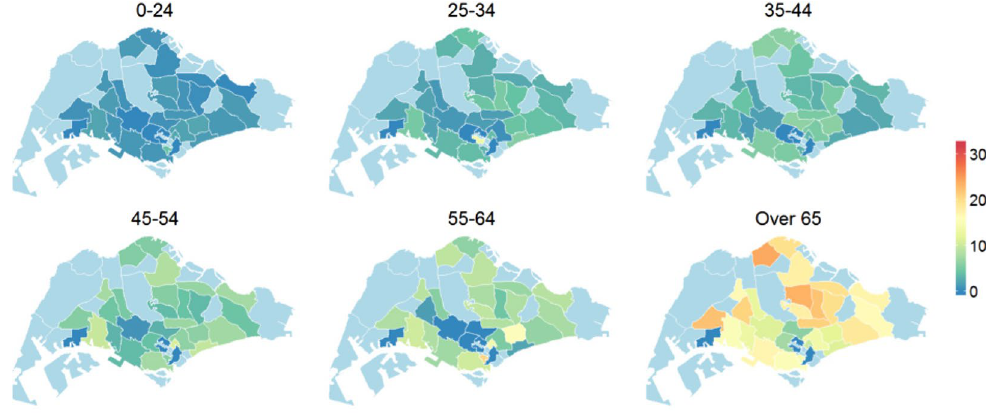
Figure 5. Age and zonal distribution of TB among resident Singaporeans in the year 2000. The values are adjusted for the population size and expressed per 10,000 of the susceptible population. Plots were created in statistical program R 22 using the package spatstat 19 . Administrative and national political coordinates of Singapore were provided, for academic research and publication, by the Singapore Land Authority (SLA) 24 .